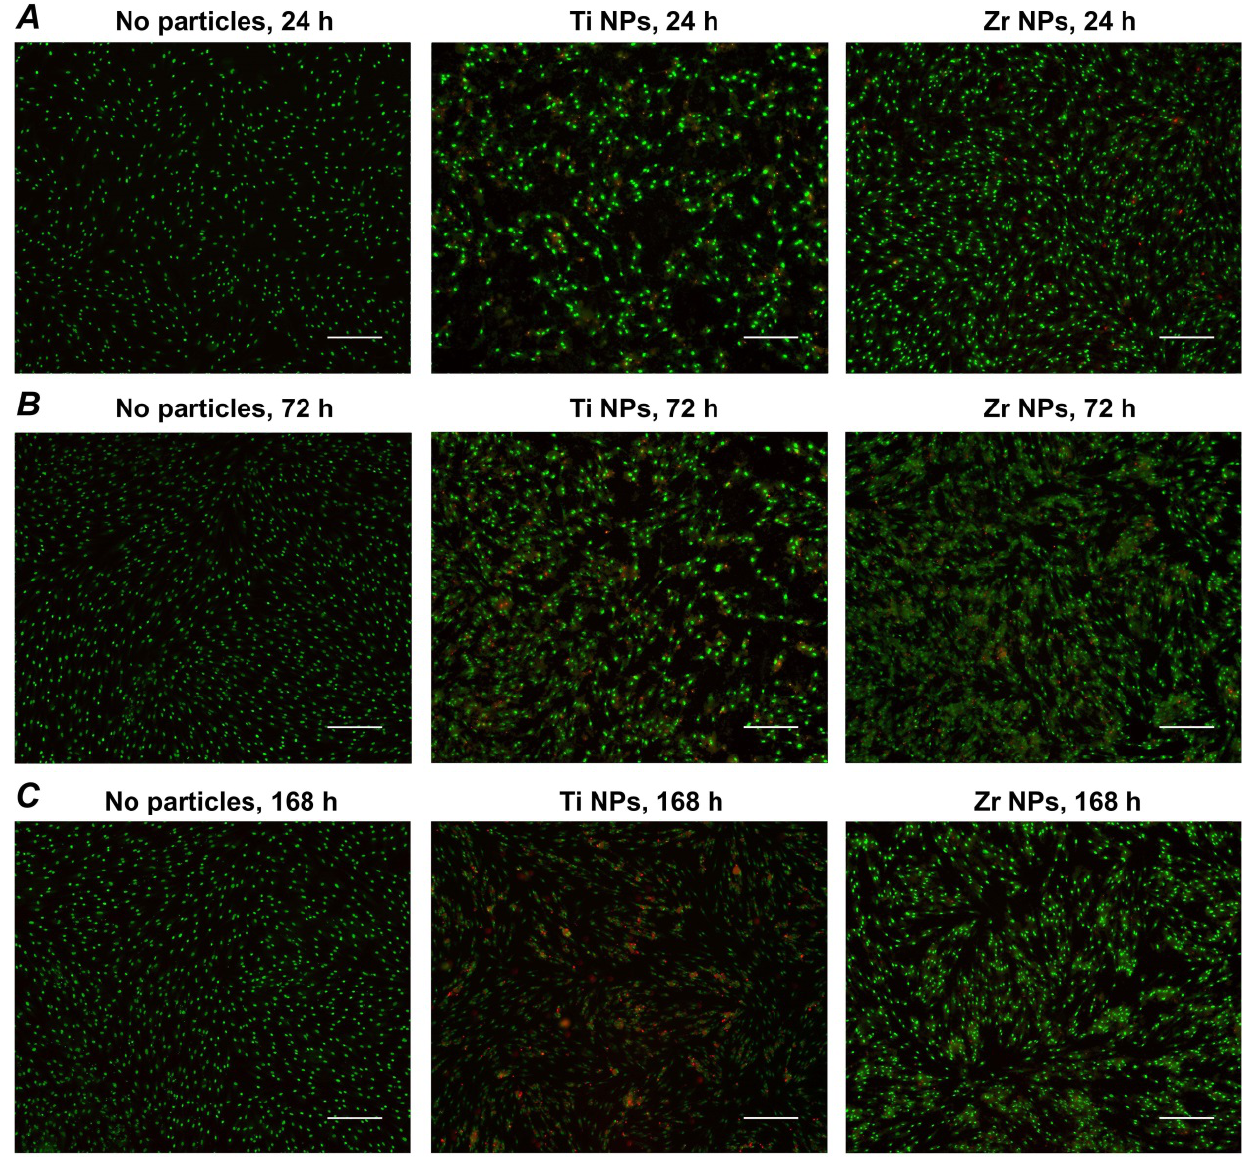
Figure 2. Live–dead staining of hG-MSCs cultured with or without different NPs. The hG-MSCs were cultured in the absence or in the presence of Ti NPs or Zr NPs at a concentration of 1000 µg/mL for 24 h ( A ), 72 h ( B ), or 168 h ( C ) and stained with a live–dead staining kit. Viable and dead cells are visualized in green and red, respectively. Images were taken from a representative experiment. The scale bar corresponds to 200 µm.